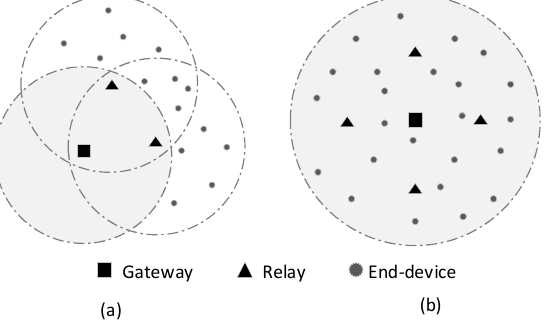
Figure 6. Two network topologies for the experiment. ( a ) Topology 1: The end devices are outside the gateway coverage. ( b ) Topology 2: The end devices are inside the gateway